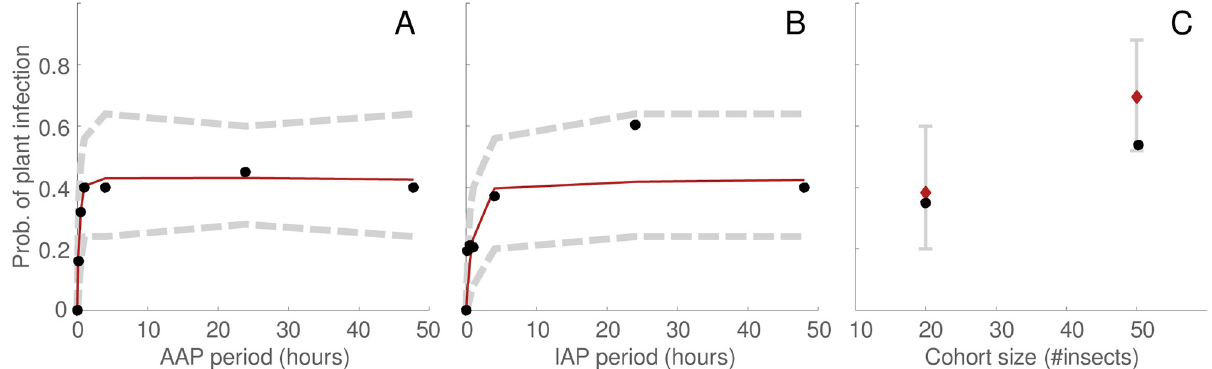
Fig 4. An empirical test of the epidemiological parameter estimates for CBSV: Dynamic simulation vs experimental data for variable acquisition period (A), for variable inoculation period (B), and for variable initial insect density (C). In A-C ruby curves/diamonds indicate the mean of simulations, gray curves/intervals indicate the 2.5th and 97.5th percentiles of simulations (i.e., demarcate 95% of simulations). Black circles indicate data-points from Maruthi et al . [1]. In A-C, dynamic simulations were implemented using the epidemiological parameter estimates for CBSV in Table 3. For details of the simulation procedure see caption of Fig